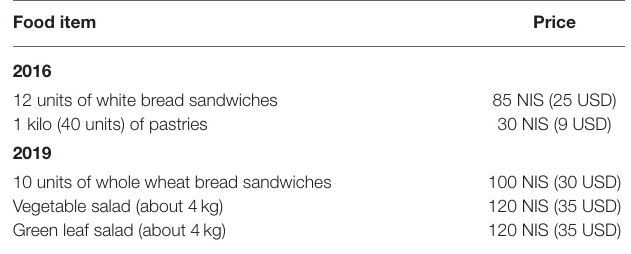
TABLE 1 | Email interest in health and nutrition (December, March, and June are the 3 months where there is daily student attendance—no college holidays).